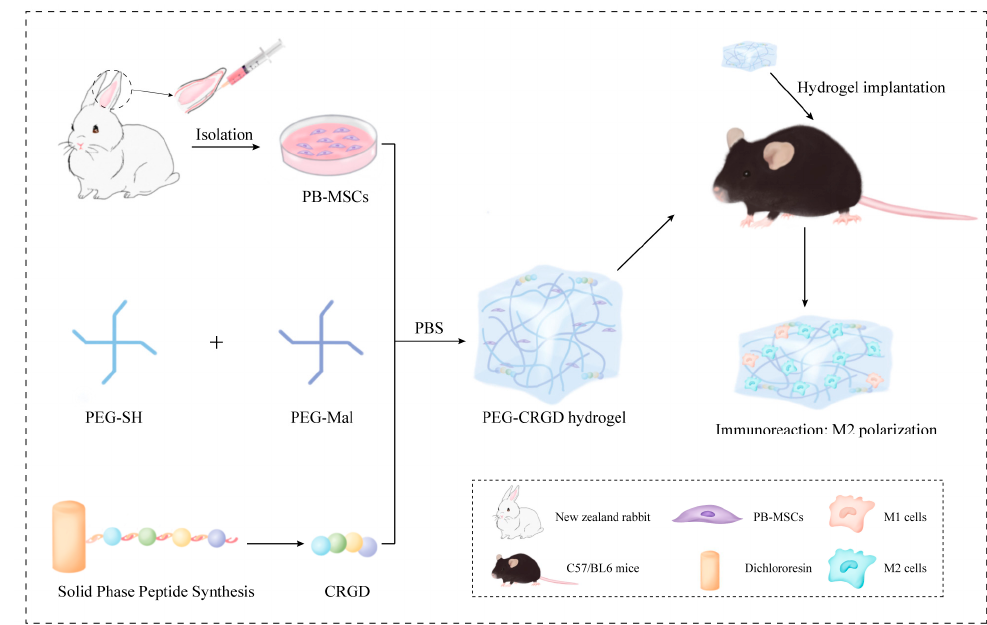
Figure 1. Illustration of PBMSCs in PEG-CRGD hydrogels.